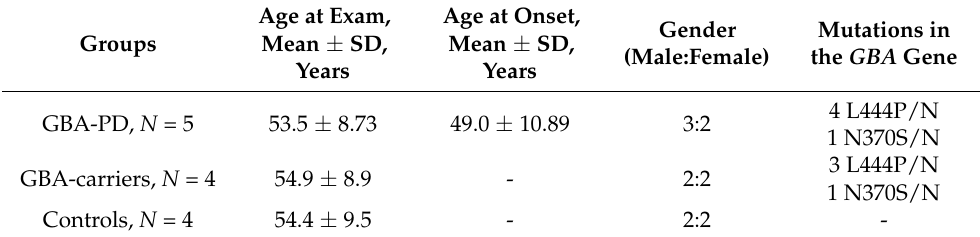
Table 1. Demographic characteristics of the compared groups.